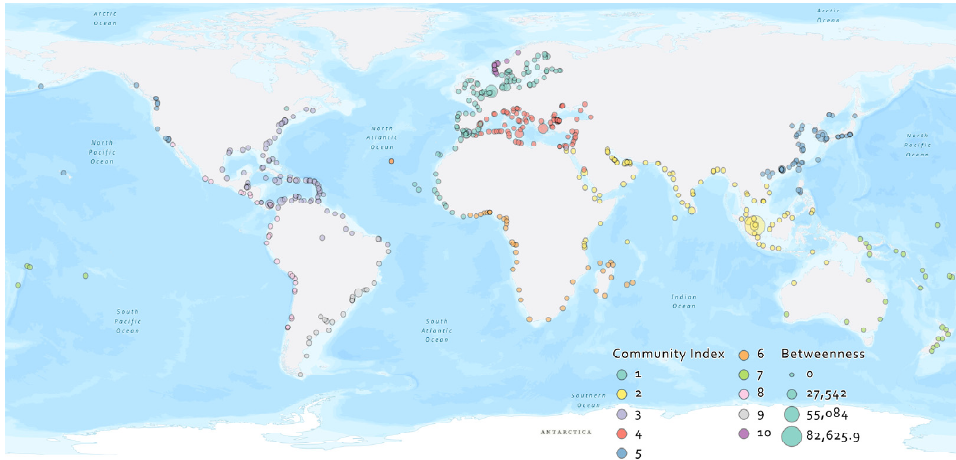
Figure 6. Communities detected in GLSN. Nodes are represented in their real coordinates (7 out of 564 ports that were not strongly connected to the major component of the GLSN are excluded).